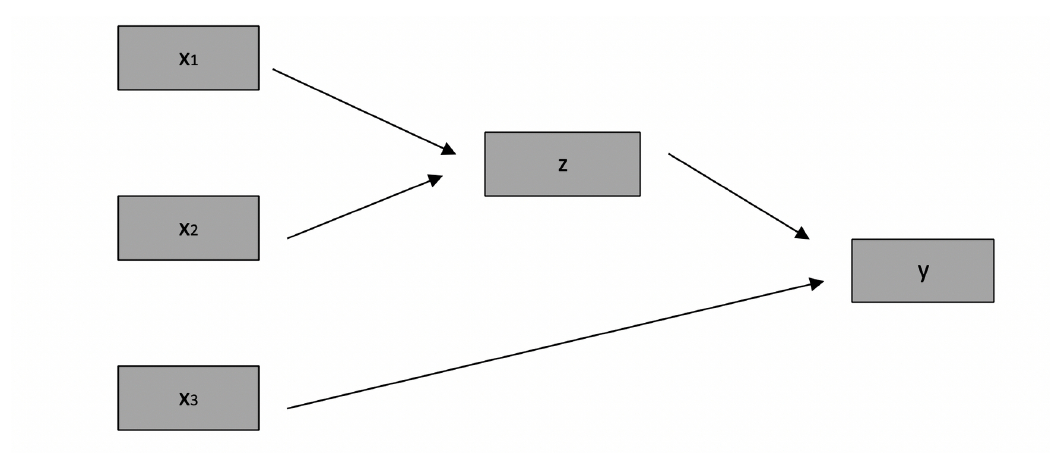
Figure 1: The General Linear